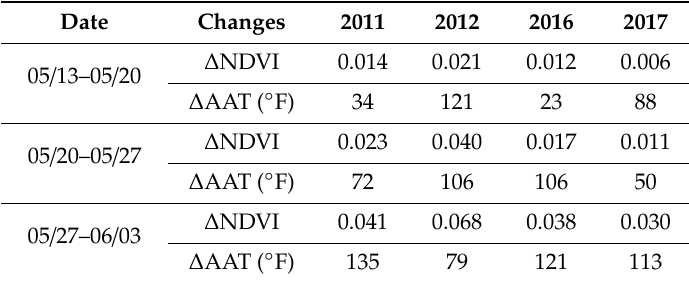
Table 4. Weekly changes of corn NDVIs and AATs in Carroll County at corn emergence period of di ff erent years. In the week of May 13th to May 20th (05 / 13–05 / 20) of 2011, ∆ NDVI and ∆ AAT are 0.014 and 34 ◦ F, respectively, which means that the corn NDVI has changed 0.014 after it receives 34 ◦ F ∆ AAT during the